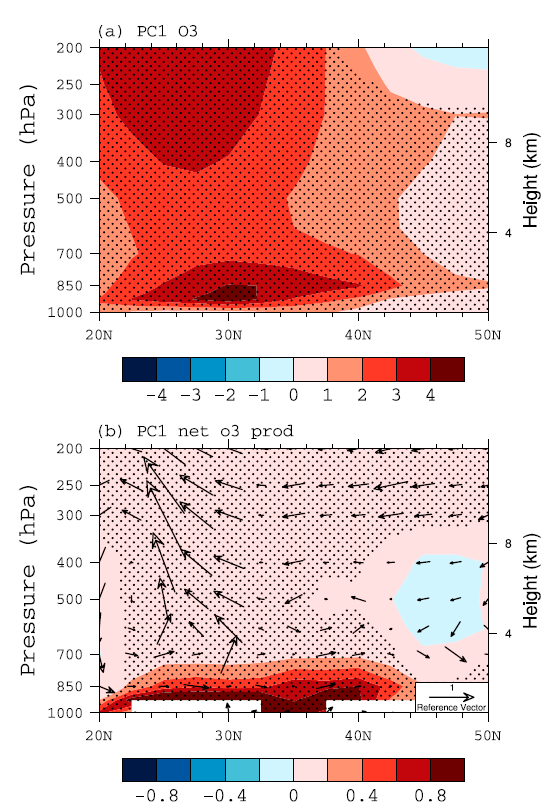
Figure 4. The regressed fields of ( a ) ozone (ppbv) and ( b ) net ozone production (shaded; × 10 − 12 mole m − 3 s − 1 ) overlaid with meridional–vertical circulations (vector; v, -omega) averaged over 110° E–120° E against PC1 (blue line in Figure 2c) during summer. Black dots indicate statistical significance at the 90% confidence level based on a Student’s t-test.